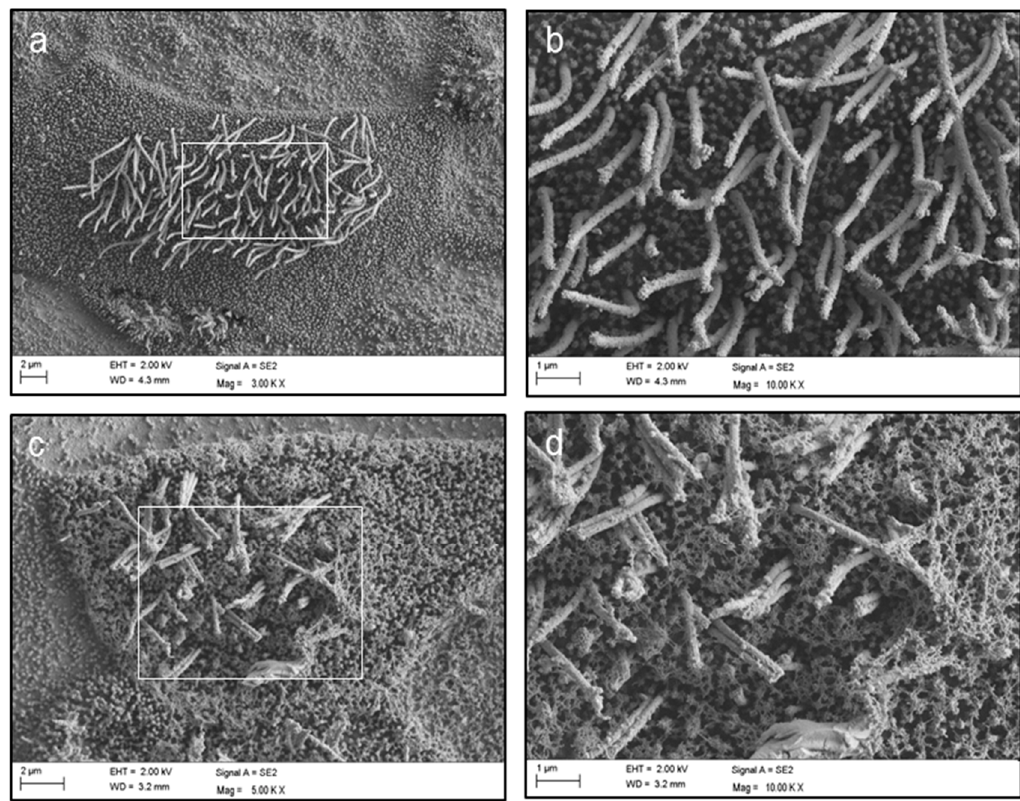
Figure 5. Scanning electron microscopy of mock- and HBoV-infected CuFi-8 cells. Scanning electron microscopy was used to analyze changes of the cellular surface of CuFi-8 ALIs after HBoV infection. ( a ) HBoV-negative CuFi-8 cells with a well-defined glycocalyx and functional cilia; ( b ) enlarged section of ( a ); ( c ) HBoV-positive CuFi-8 cells, which show an abnormal glycocalyx structure and destroyed cilia sticking together in bundles; ( d ) enlarged section of ( c ).